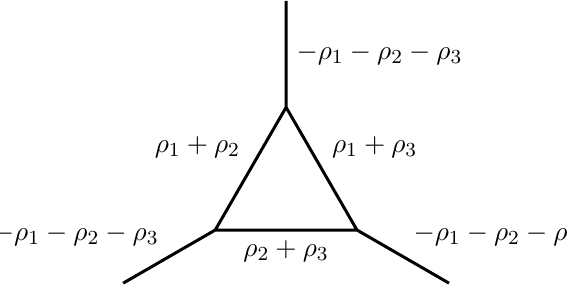
Figure 2 . Gluing diagram for N = 2 supersymmetric Grassmannian. The parameters are the values of (cid:23) j parameters associated to the corresponding legs. The gluing parameter p = 1 and " = 1 for all three